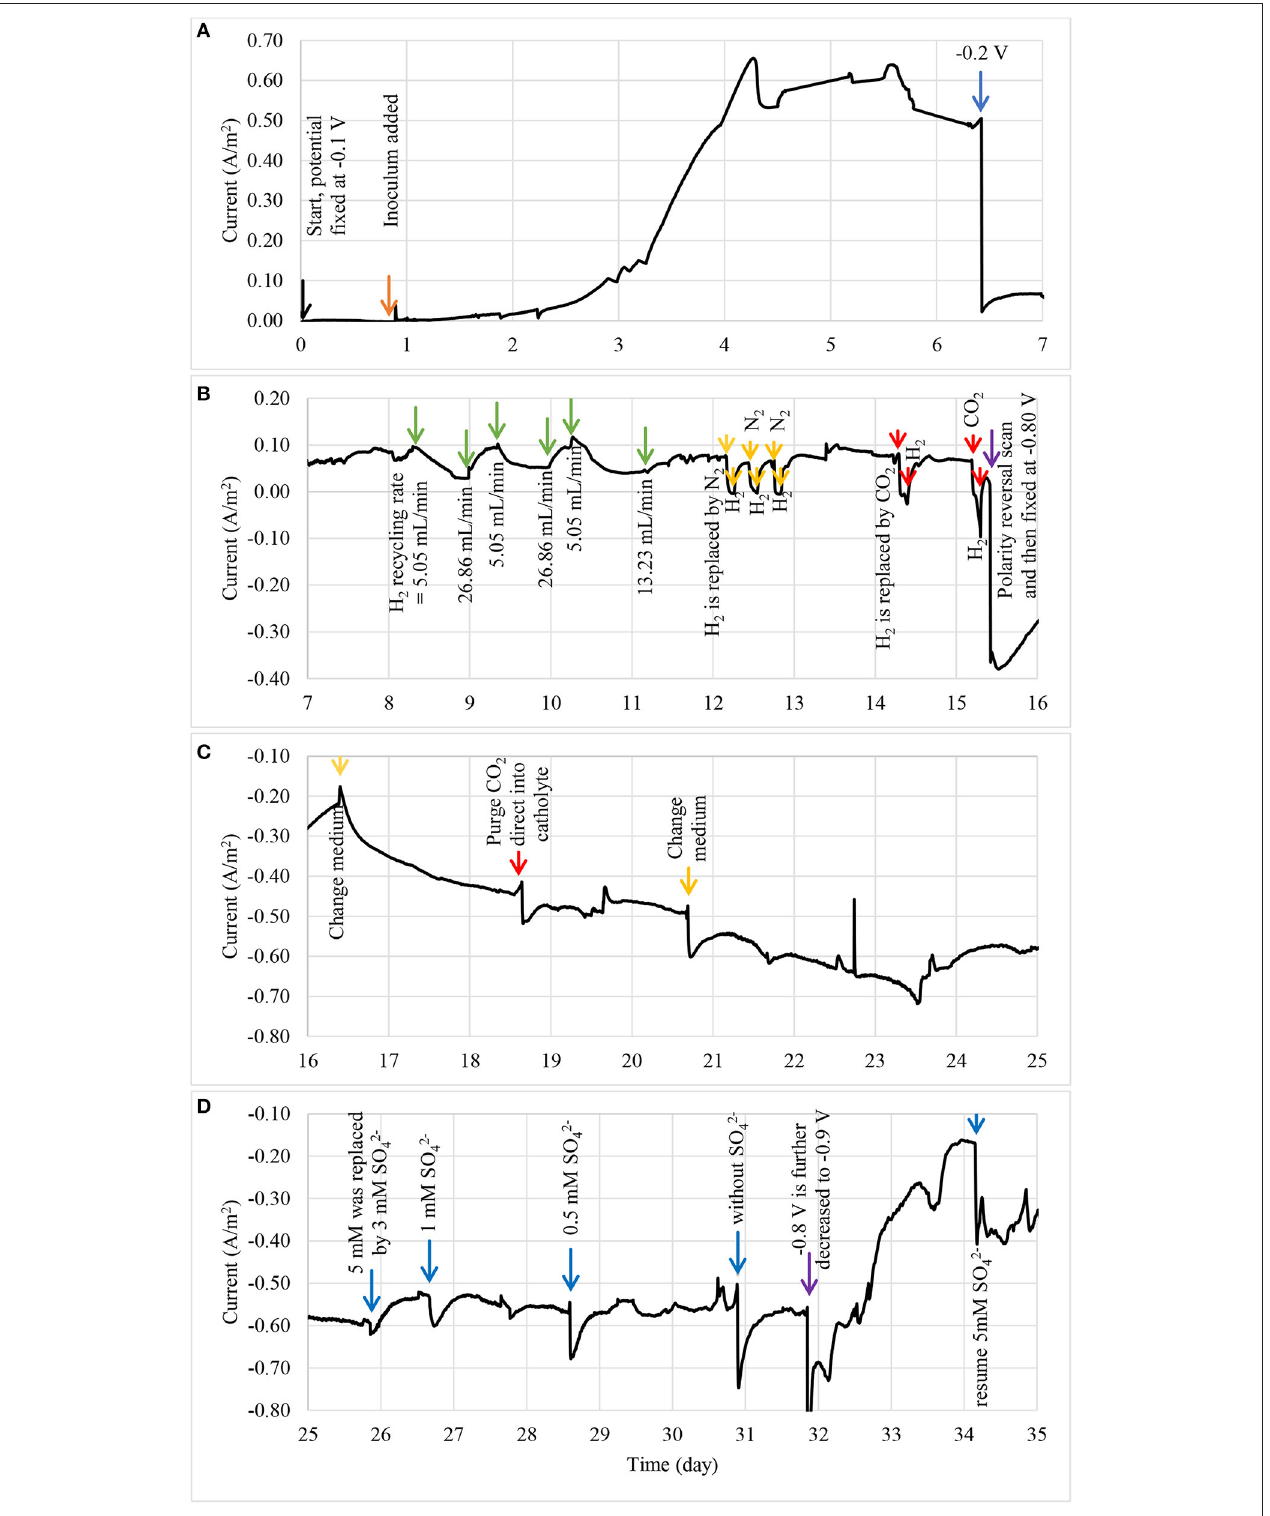
FIGURE 2 | The current density profile of enriched bioelectrode using three step start-up procedure: (A) bioelectrode was enriched as bioanode between 0 and 7 day, and (B) subjected to series of bioanode confirmation tests between 7 and 16 day, (C) the bioanode was then switched to biocathode and grew under a fixed potential of − 0.8V between 16 and 25 day, and (D) subjected to sulphate tests after a stable current was observed between 25 and 35 day.